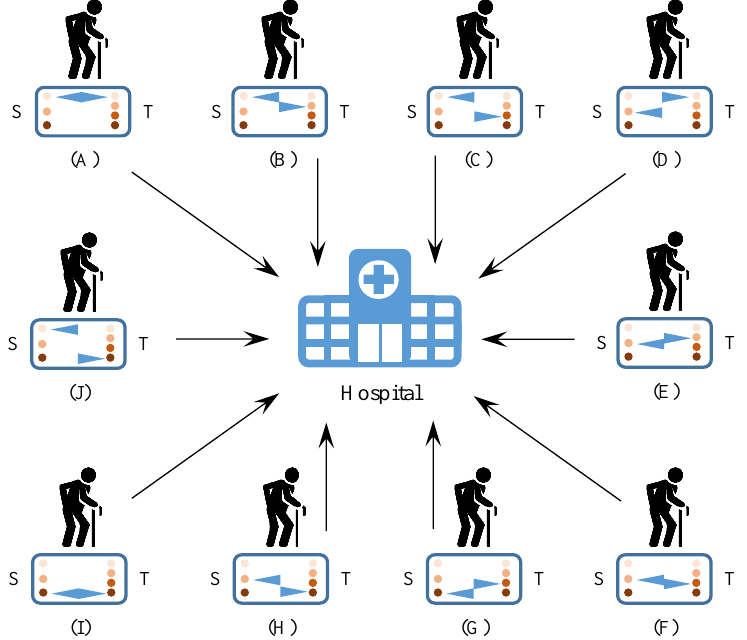
Figure 7. Different daily activity monitoring scenarios in the simplified healthcare network. In particular, S indicates user control policies for data storage, while T indicates user control policies for data transmission. (A) Store nothing and transmit nothing. (B) Store nothing and transmit regular handshakes and/or occasional notifications. (C) Store nothing and transmit analytic result. (D) Store analytic result and transmit nothing. (E) Store analytic result and transmit regular handshakes and/or occasional notifications. (F) Both store and transmit analytic result. (G) Store raw data and transmit analytic result. (H) Store analytic result and transmit raw data. (I) Both store and transmit raw data. (J) Store nothing and transmit raw